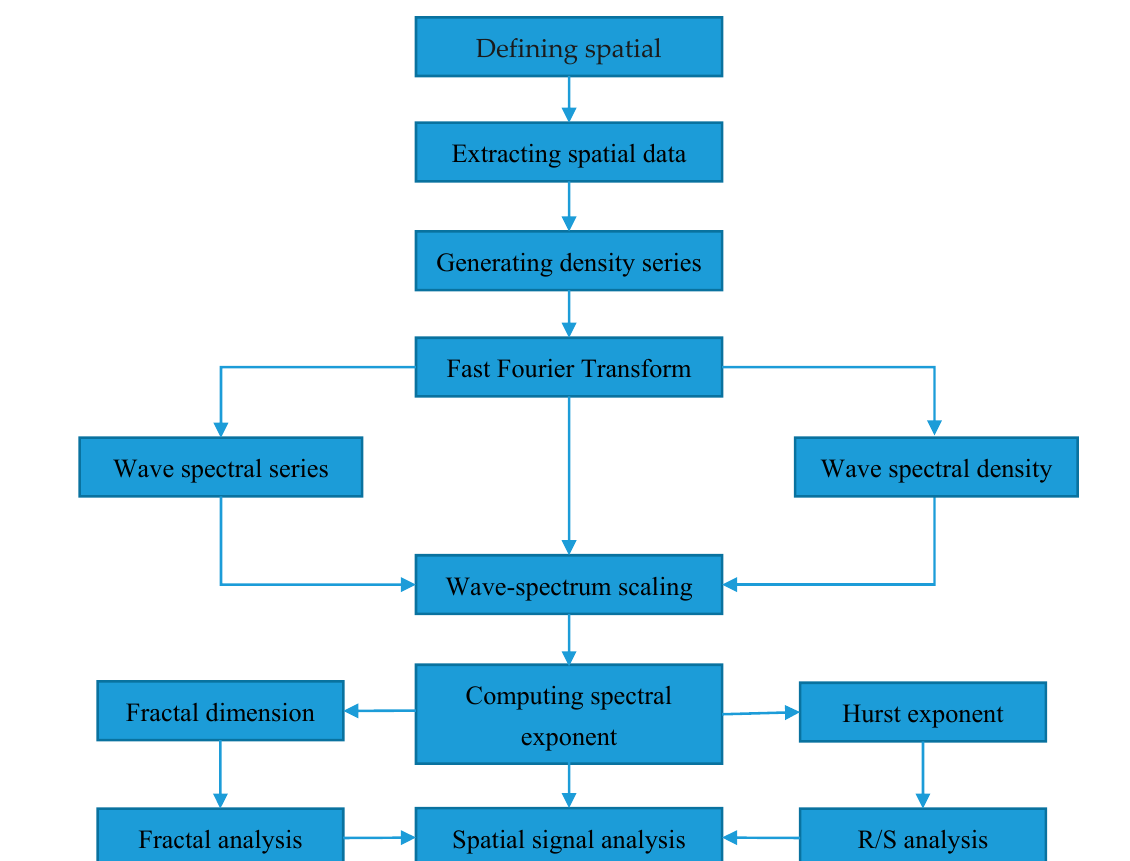
Figure 2. A flow chart of fractal-based spatial signal analysis for geographical systems. Note: The wave spectral series is based on Equations (4) and (6) as well as Equations (16) and (17), the wave-spectrum density is based on Equations (9) and (10).